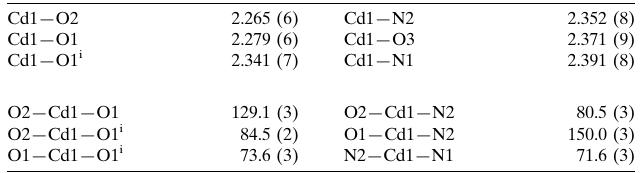
Selected geometric parameters (A˚ , (cid:1)